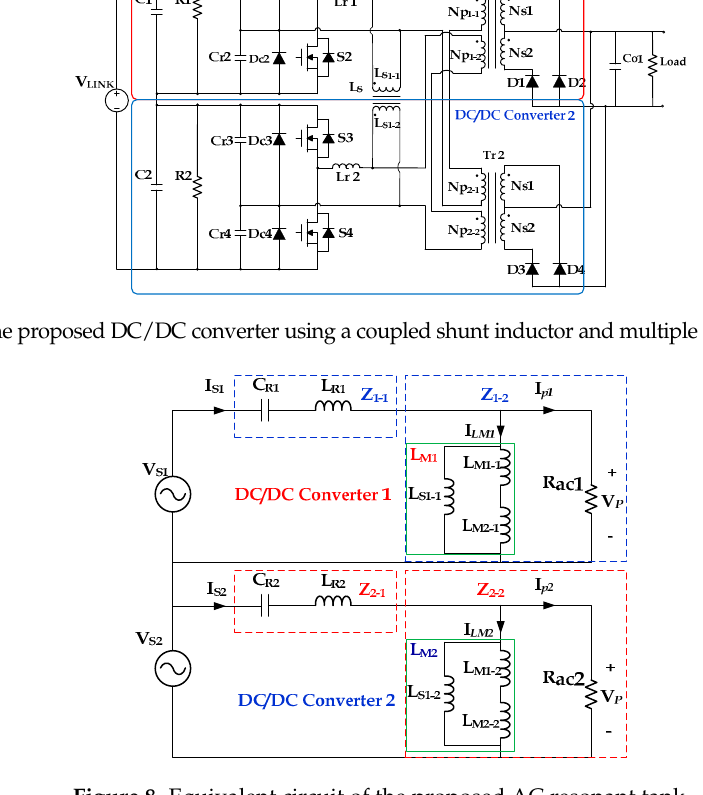
Figure 8. Equivalent circuit of the proposed AC resonant tank.